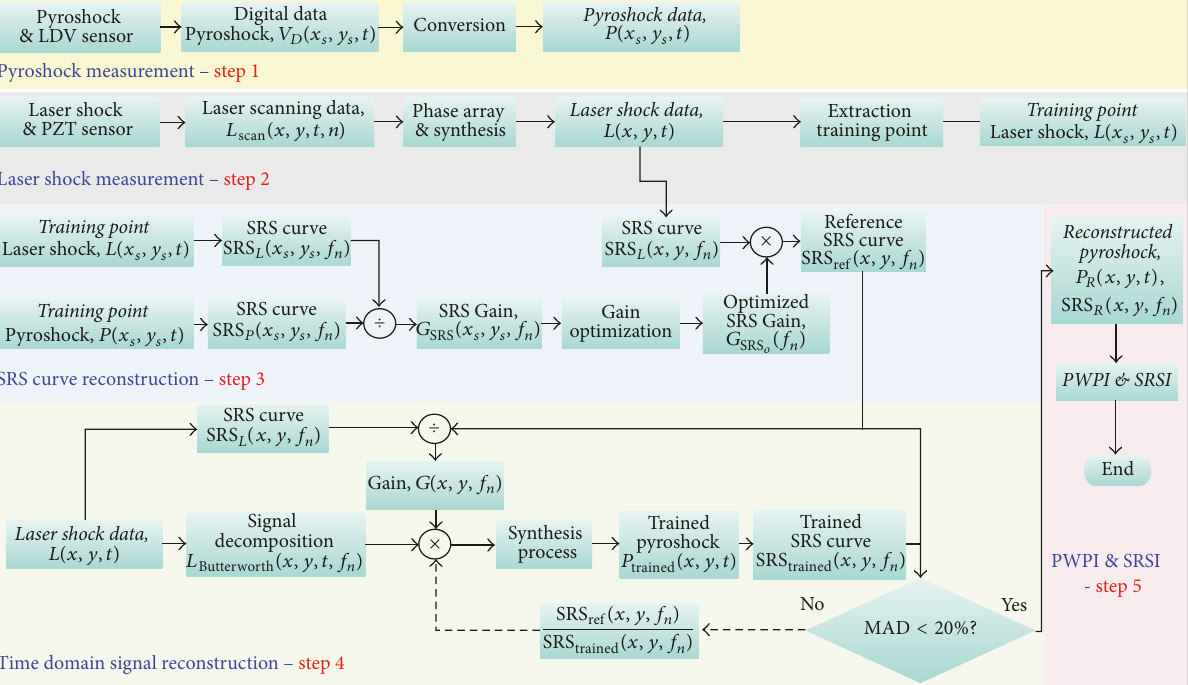
reciprocal setup of the laser shock scanning system (Mobile PZT-UPI, X-NDT Inc.) designates the sensor locations